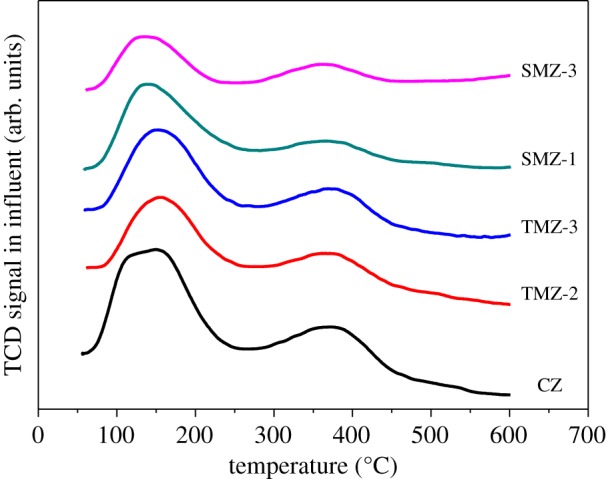
NH3-TPD curves of the H-form SMZ and TMZ samples and the sample of CZ.